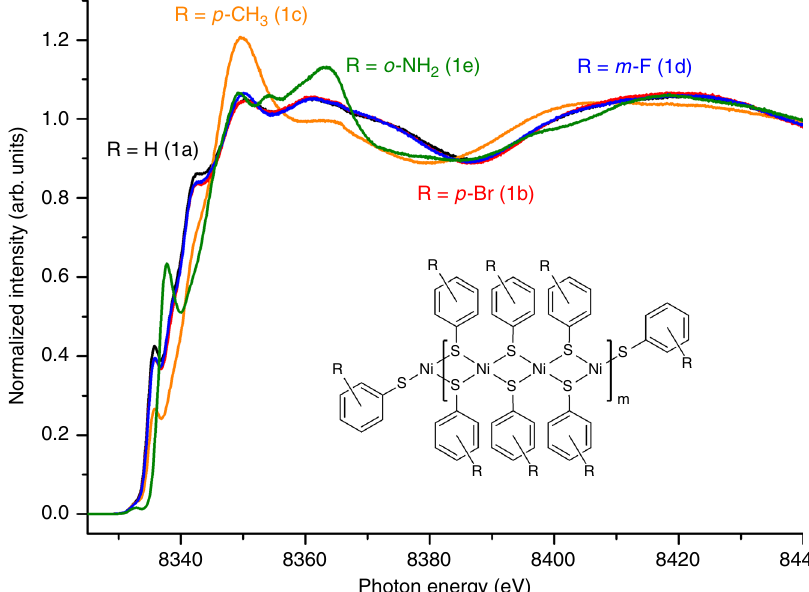
Fig. 3 XAS analysis of selected nickel thiolates. Ni K-edge HERFD-X-ray absorption near edge structure (XANES) spectra of nickel thiophenolate ( 1a ) and nickel thiolates with p -Br ( 1b ), p -CH 3 ( 1c ), m -F ( 1d ), and o -NH 2 ( 1e ) substituents in the aromatic